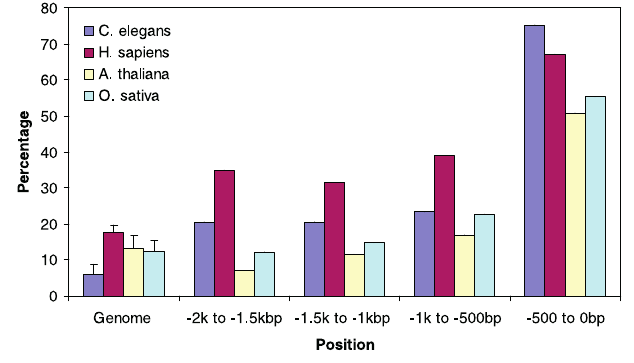
Figure 3. The Distributions of CT